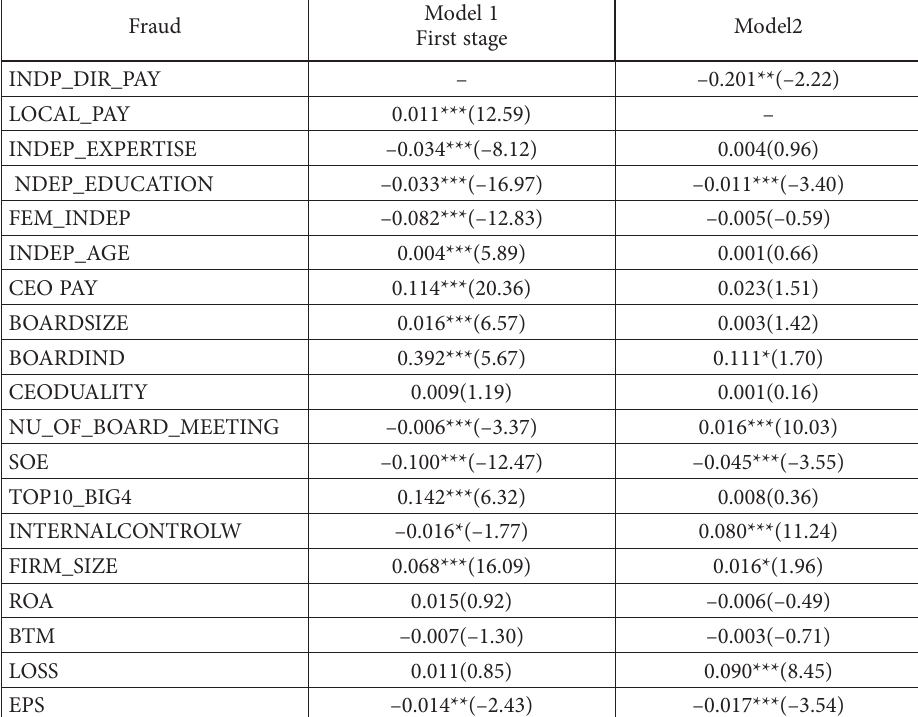
Table 6. Result of the two stages least squares